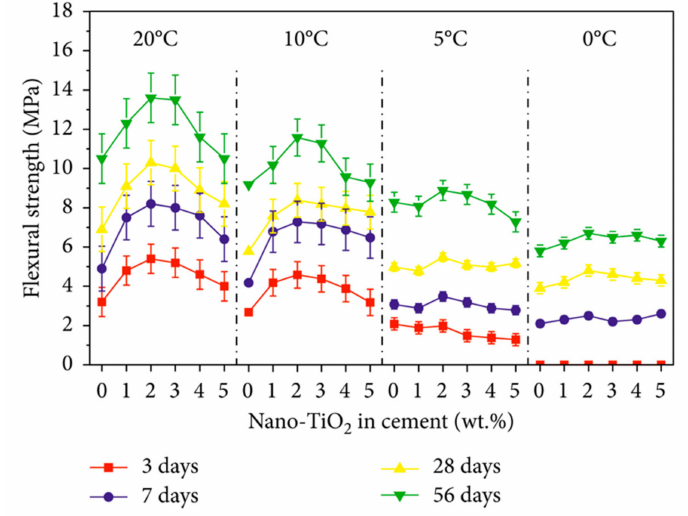
Figure 13. Flexural strength of cement mortar samples containing di ff erent nano-TiO 2 dosages. Reprinted with permission from [97]. Copyright © 2018,